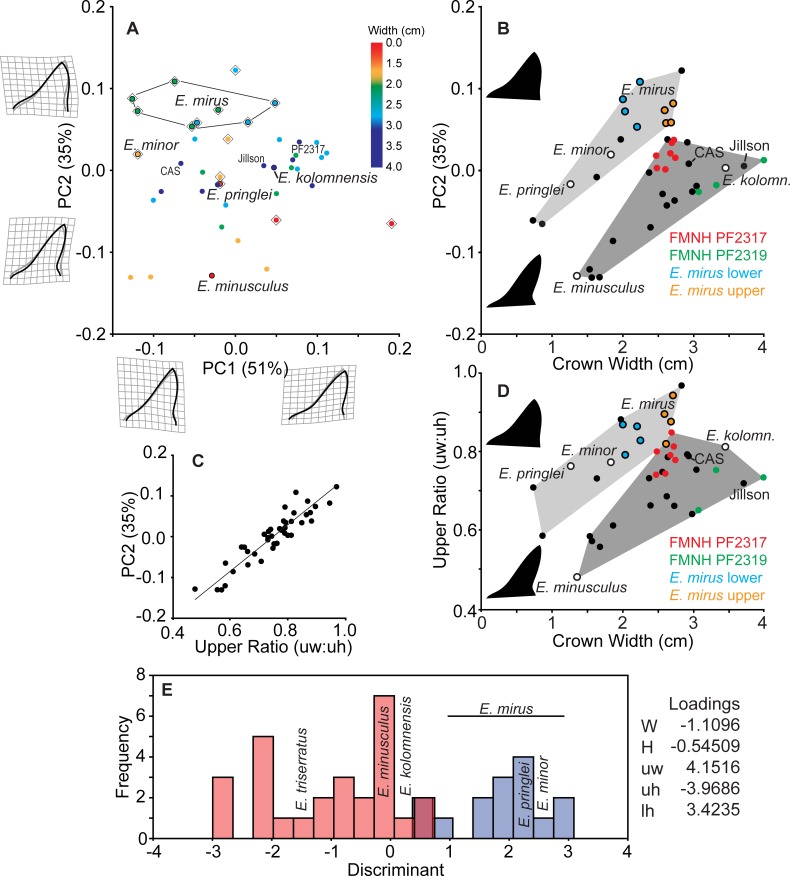
Geometric morphometrics of all Edestus specimens.Type specimens are outlined with black circles. Holotype E. mirus crowns from upper and lower whorls shown in red and blue circles, respectively.